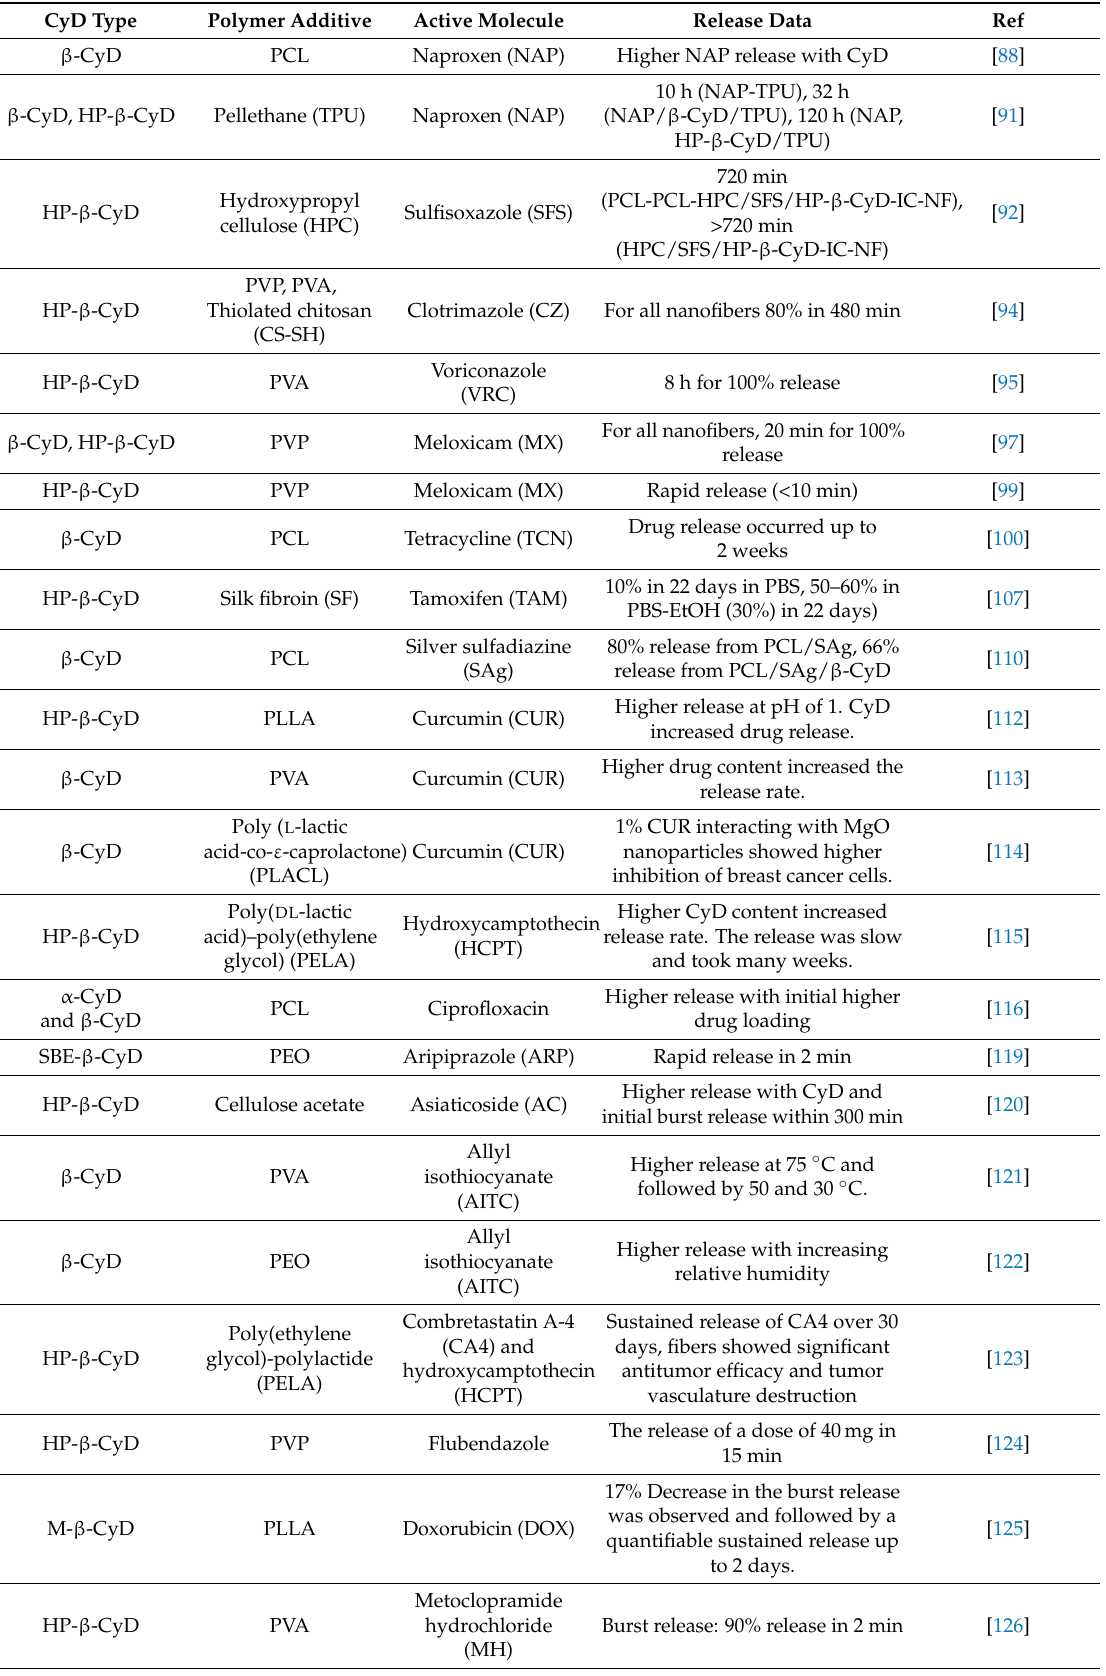
Table 1. General overview of CyD/drug ICs embedded polymeric electrospun nanofibers used in drug